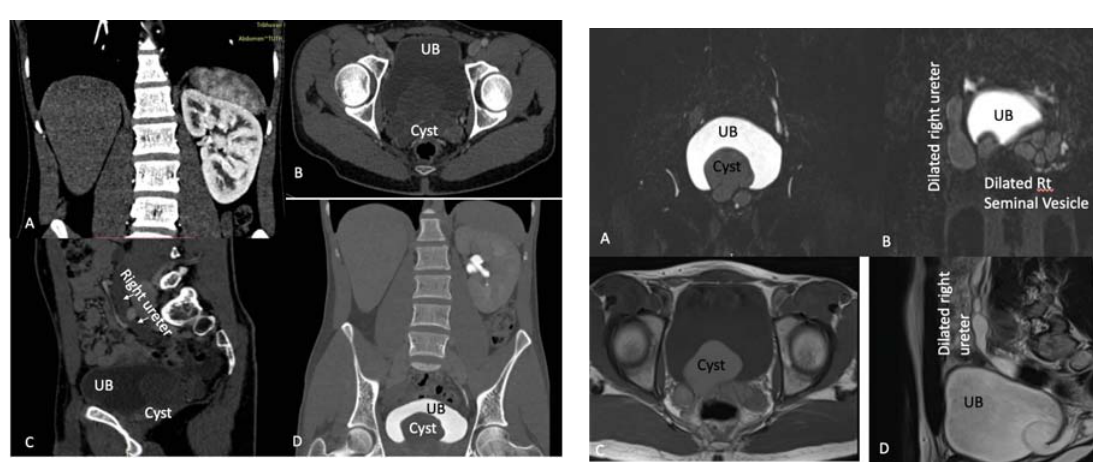
TRUS as MR Urography is considered the gold standard dilated right seminal vesicle which was protruding into the (cid:88)(cid:85)(cid:76)(cid:81)(cid:68)(cid:85)(cid:92)(cid:3)(cid:69)(cid:79)(cid:68)(cid:71)(cid:71)(cid:72)(cid:85)(cid:3)(cid:68)(cid:87)(cid:3)(cid:87)(cid:75)(cid:72)(cid:3)(cid:85)(cid:76)(cid:74)(cid:75)(cid:87)(cid:3)(cid:57)(cid:56)(cid:45)(cid:17)(cid:3)(cid:55)(cid:75)(cid:72)(cid:3)(cid:83)(cid:68)(cid:85)(cid:87)(cid:76)(cid:68)(cid:79)(cid:79)(cid:92)(cid:3)(cid:73)(cid:82)(cid:85)(cid:80)(cid:72)(cid:71)(cid:3)(cid:9)(cid:3) dilated right distal ureter was also seen draining into the cystically dilated right seminal vesicle. Signal intensity of the dilated right seminal vesicle as well as dilated right ureter showed T1 mild hyperintensity and lower signal intensity as compared to bladder content in urography images.